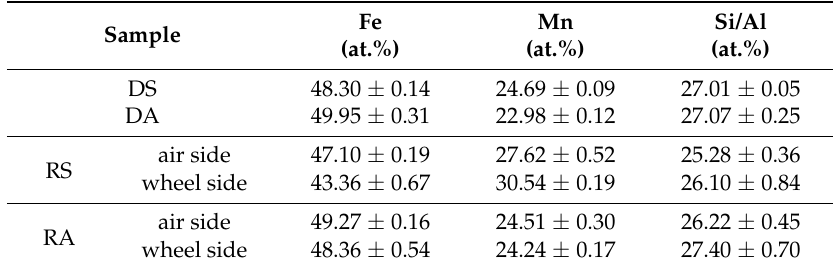
Table 1. Chemical composition taken from an area of about (1 × 1) mm 2 of the Fe 2 MnSi and Fe 2 MnAl samples prepared by arc melting (DS, DA) and planar flow casting (RS,